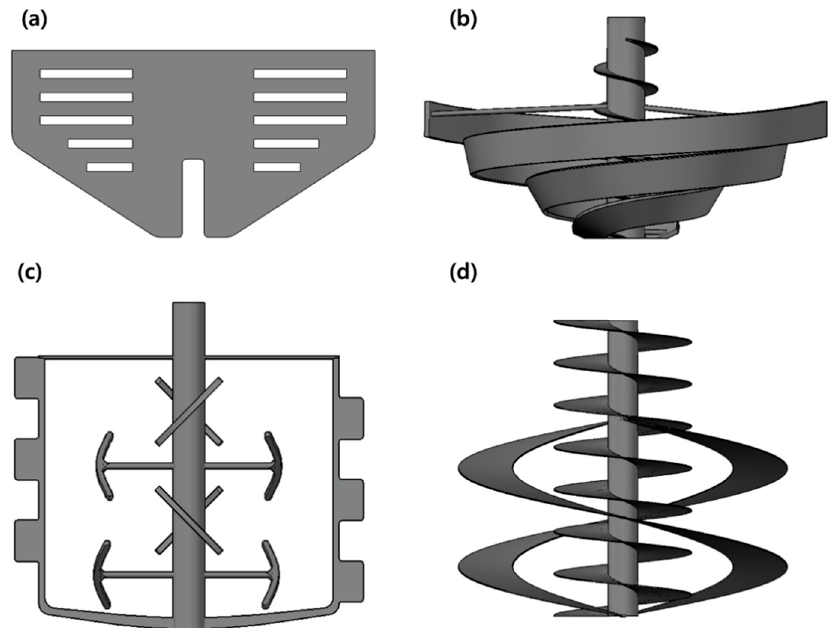
Figure 3. The dimension of chamber geometry.